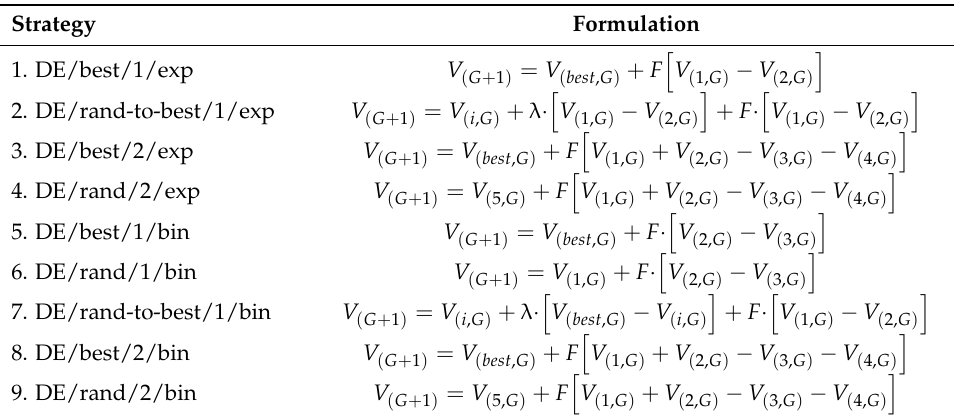
Table 1. The differentiation operation can be carried out using many mutation strategies. Strategy